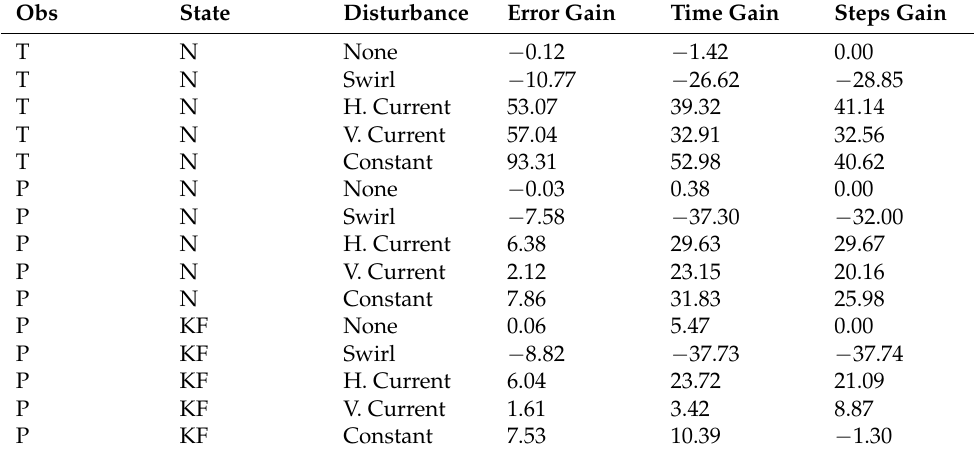
Table 2. CDE results, where observation is total (T) or partial (P), and the state estimator used is none (N) or a Kalman filter (KF). For all gains, higher is better. Note that the results are competitive against FDE, but having a significantly lower computational cost (except on the swirl).